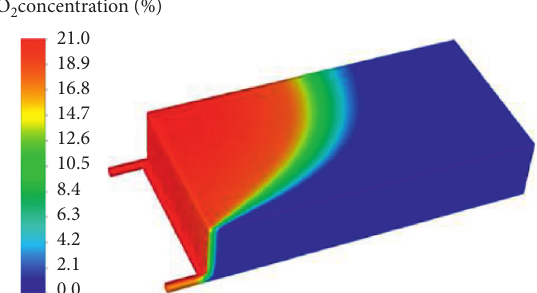
Figure 15: Oxygen concentration in gob